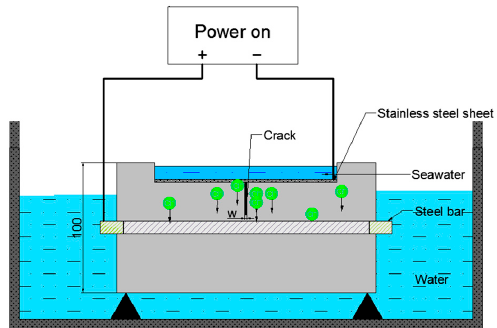
Figure 1. Diagram of potentiostatic accelerated corrosion of reinforced concrete.